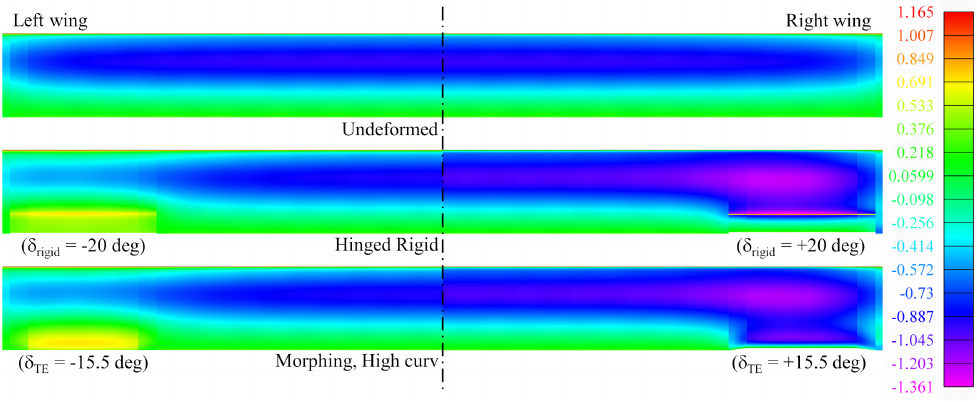
Figure 11. Comparison between the pressure coefficient distribution acting on the upper surface of the wing in three different configurations ( AoA = 1 deg): clean wing (undeformed), hinged aileron rotated of ± 20 deg and optimal morphing aileron with ± 15.5 deg of equivalent